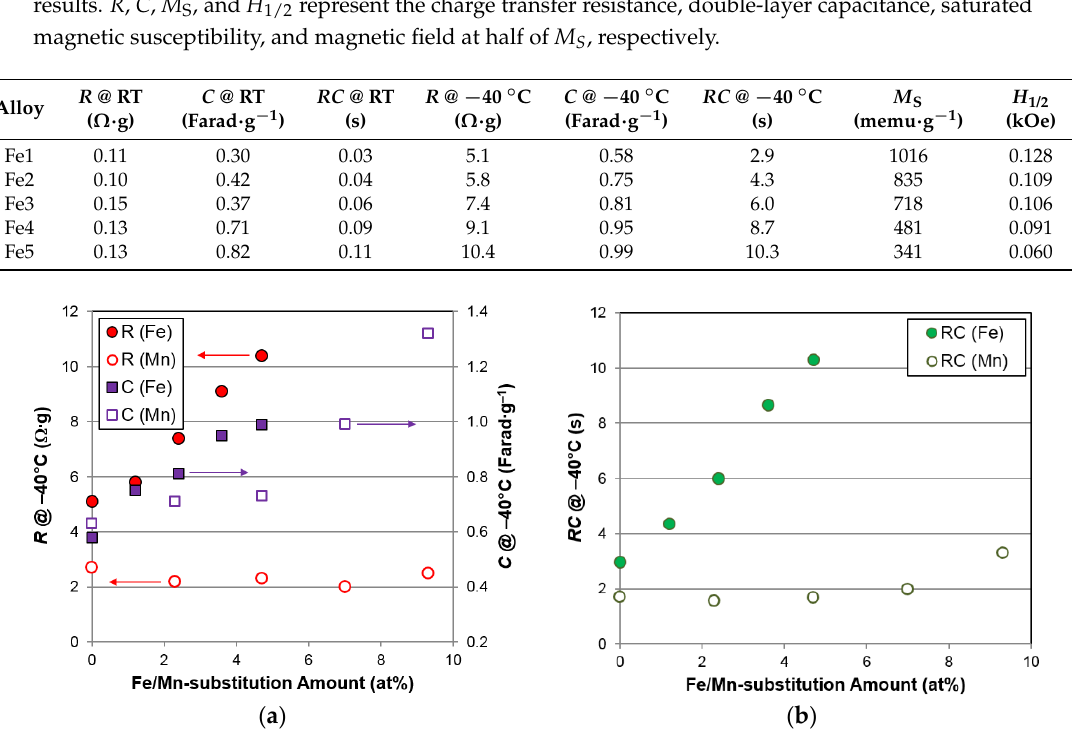
Figure 11. Changes in ( a ) charge transfer resistance ( R ) and double-layer capacitance ( C ) calculated from the AC impedance measured at − 40 °C; and ( b ) their product ( RC ) with increasing substitution amounts. A larger RC product corresponds to a slower surface electrochemical reaction and a less catalytic surface.